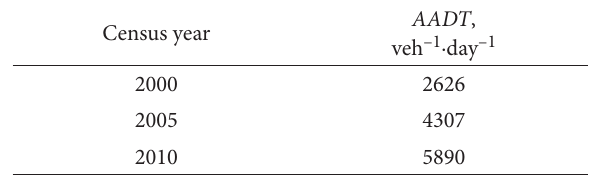
Table 6. Safety indicators for the studied curves Curve